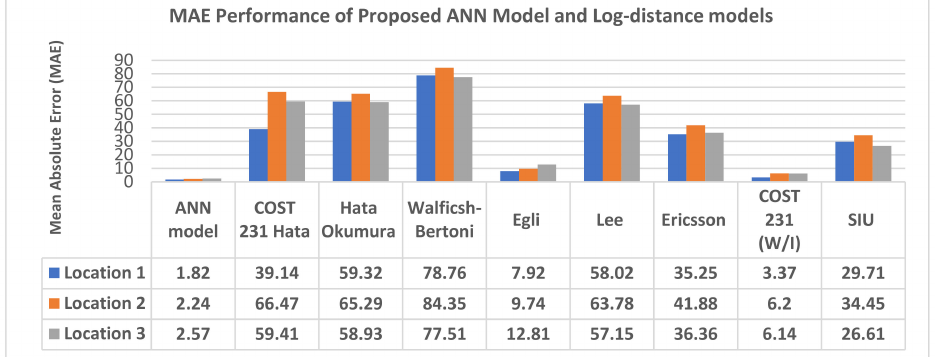
Figure 21. A comparison of mean absolute error statistics between the proposed ANN model and log-distance models on measured path loss in site locations 1, 2 and 3.